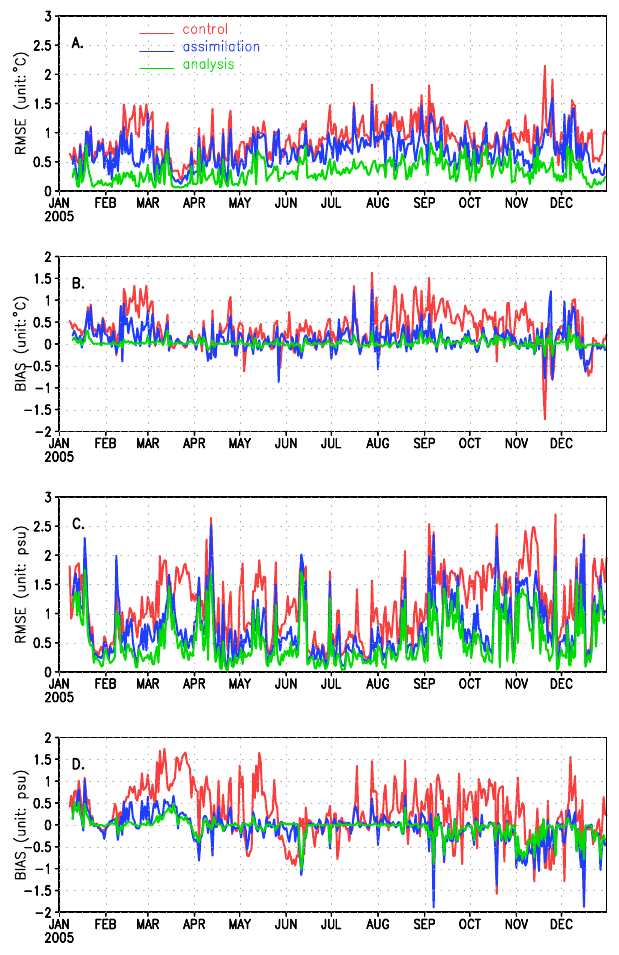
Fig. 7. The daily spatially averaged RMSE and bias of innovations (background minus observation) for the experiment with 3DVAR data assimilation (blue line), and the experiment without data as- similation (red line). The corresponding rmse and bias of analysis residual (analysis minus observation) are shown by green